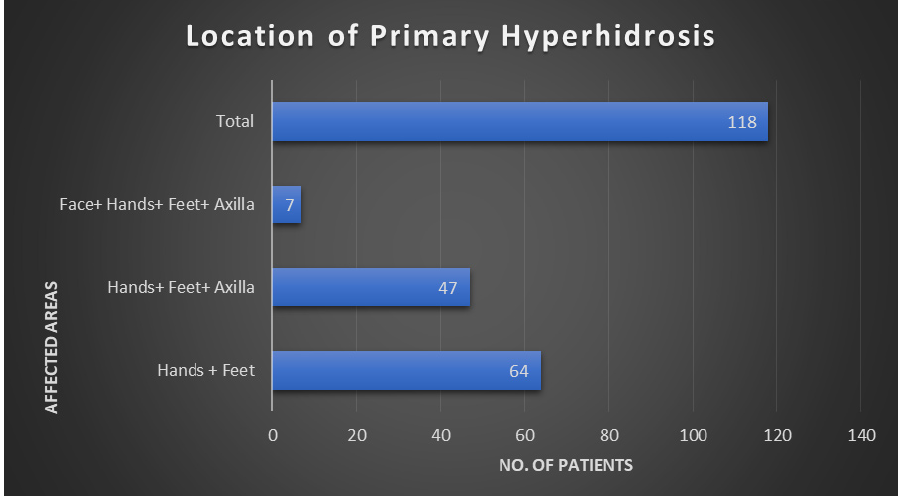
Figure 2. Distribution of primary hyperhidrosis by area affected.